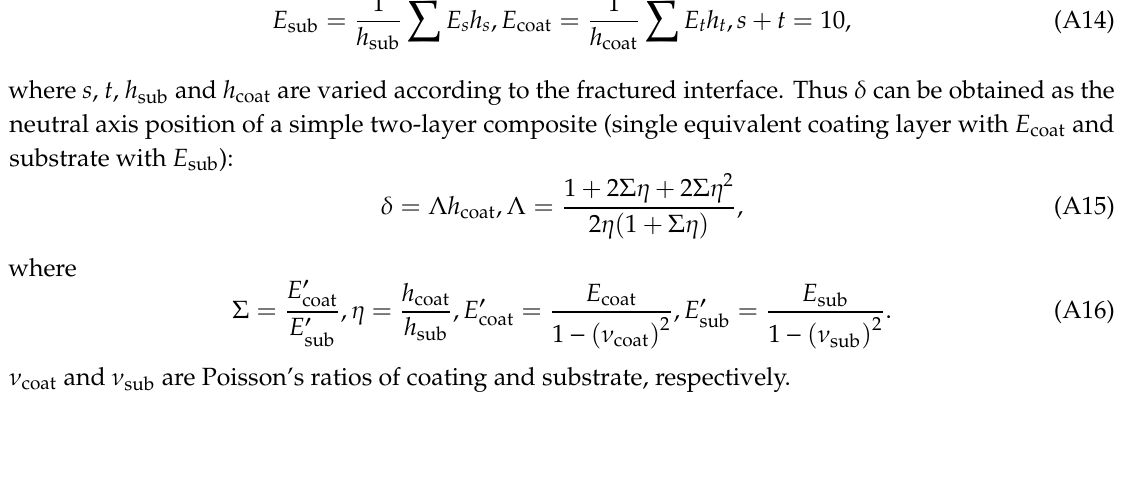
Figure A2. σ y distributions in coating layers along the y axis at the positions r x distant from right SiC/substrate interface edge in x direction.